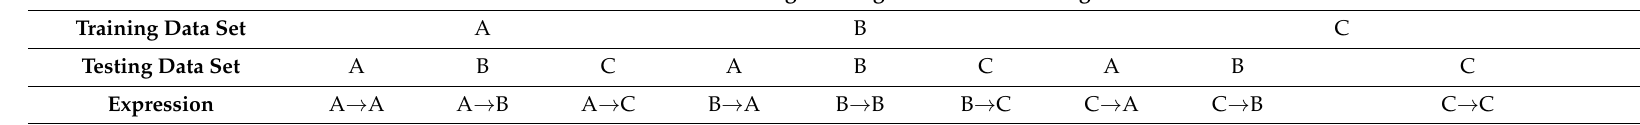
Table 5. Results of the 32 CNN